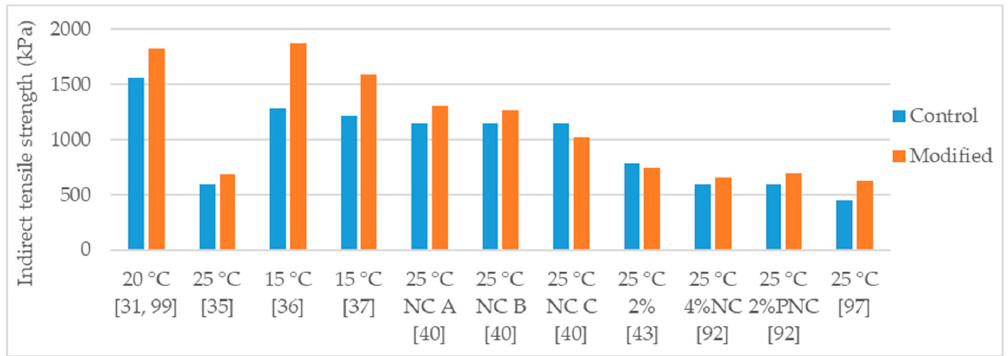
Figure 8. Indirect tensile strength of control and nanoclay modified asphalt mixtures.